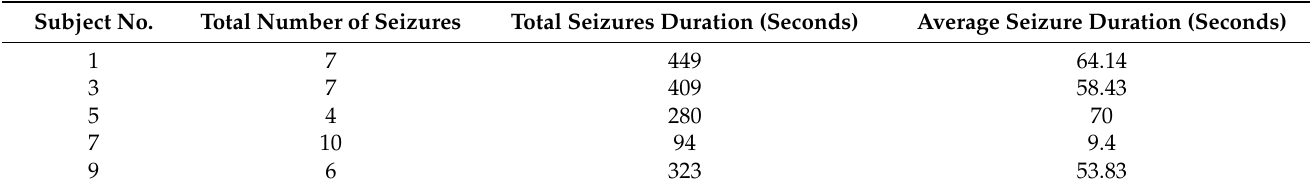
Table 4. Seizure duration for a sample of subjects in the CHB-MIT